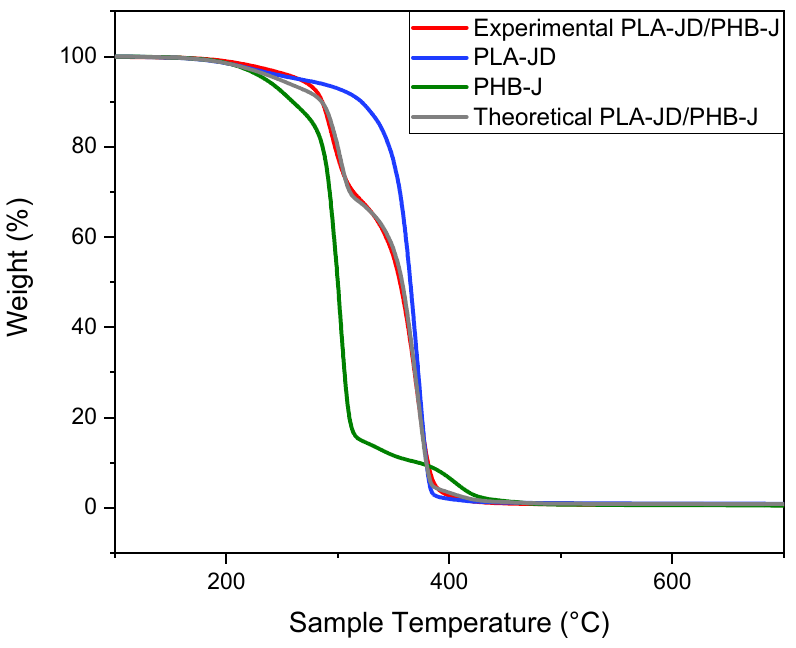
JD, PHB-J, and mixtures with and without clay as a function of temperature. It can be seen that the thermal stability decreases when PLA-JD is mixed with PHB-J. When clay is added to the PLA-JD/PHB-J blend, the thermogram of thermal degradation is identical, up to 400 °C, and then a residual mass of about 4% can be observed, corresponding to the inorganic fraction of the organo-modified clay. The presence of a degradation peak at 405 °C on the PHB-J sample can be attributed to the degradation of Joncryl ADR ® -4468. This peak does not appear on the PLA-JD/PHB-J blend, which explains an improvement in the compatibility between the two polymers with the presence of Joncryl ADR ® -4468. Figure 9. TGA curves of PLA-JD, PHB-J, and experimental and theoretical PLA-JD/PHB-J.